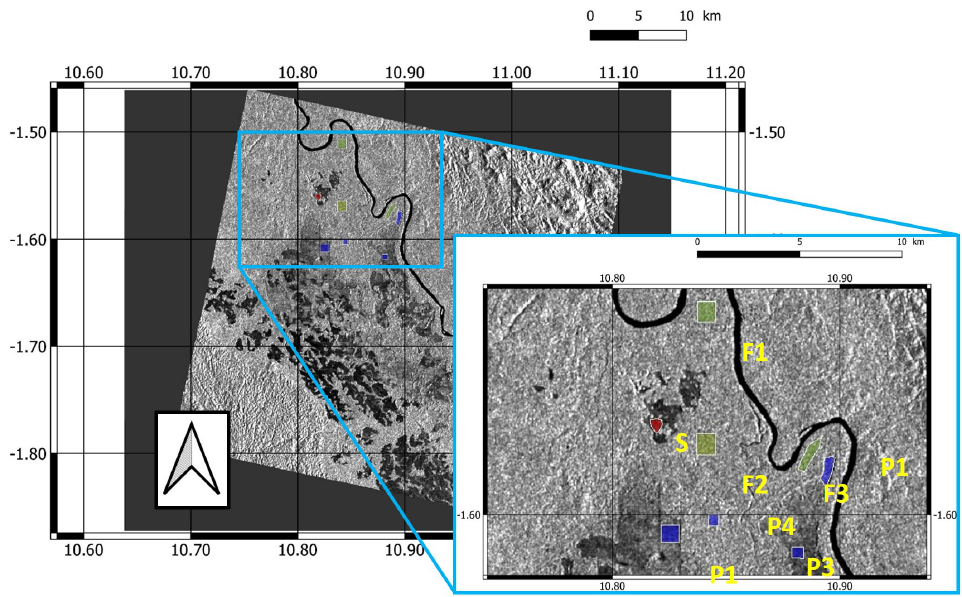
Figure 3. Zoomed view of the test site. A VV channel image acquired on 14 April 2015 and the polygons chosen for the analysis are shown. Labels F1, F2 and F3 refer to tropical forest areas; P1, P2, P3 and P4 to oil palm plantations; and S to savannah.